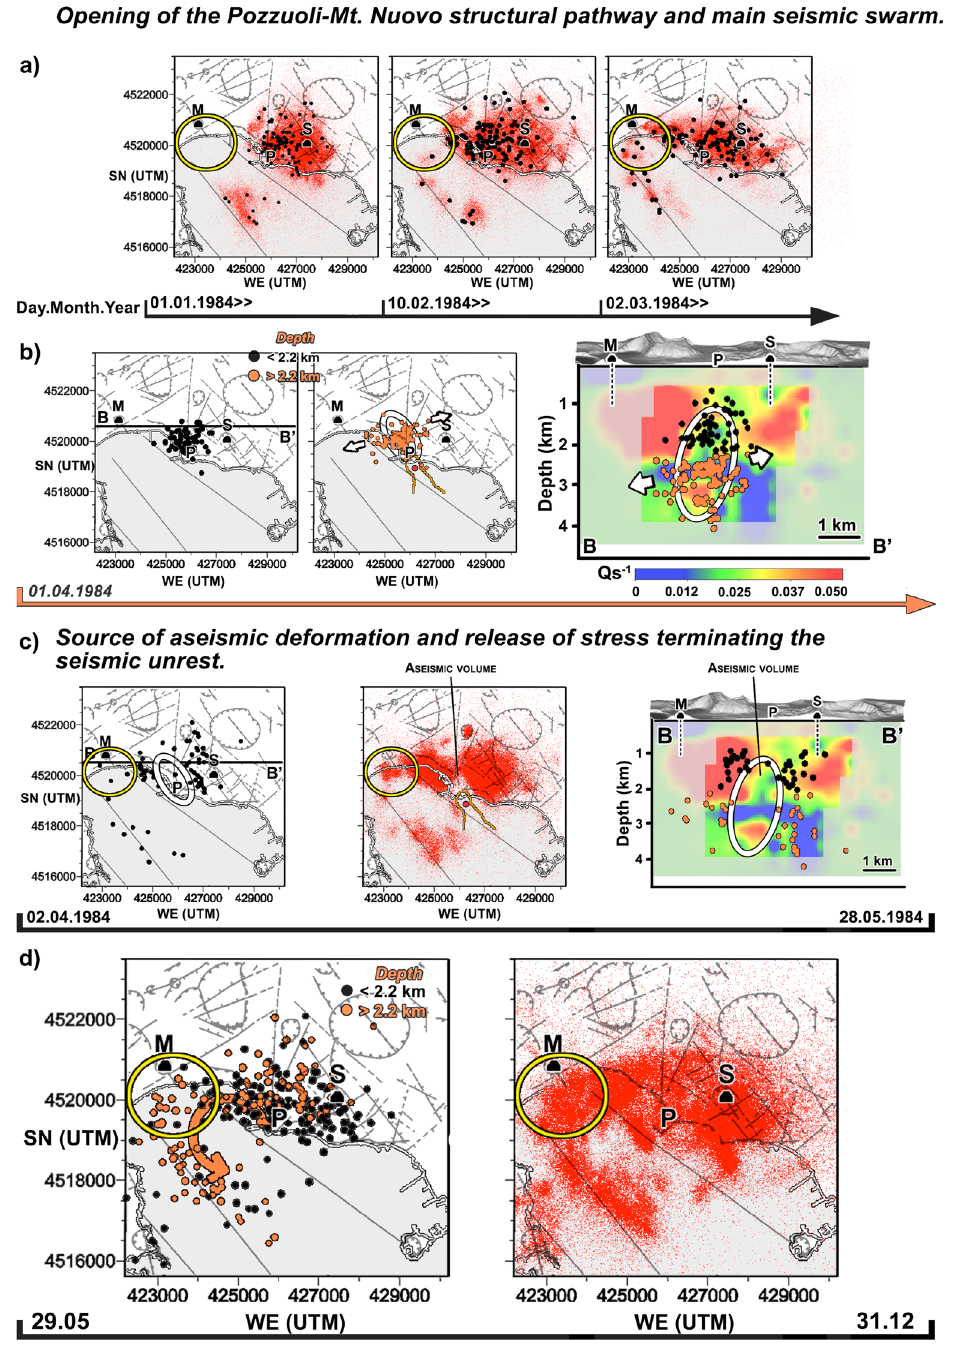
Figure 5. Time-dependent seismicity during the 1984 unrest. The symbols are the same used for Fig. 4. An 1 is plotted on all maps between January and May and depicts the 4–4.5 deep isoline corresponding to = . − Q 0 03 s high-attenuation anomaly. Panel (a) shows how the microseismicity progressively crosses the location of the last eruption, mainly following La Starza marine terrace. Panel b depicts the microearthquakes recorded on April 1: in this case, black (orange) circles are earthquakes recorded above (below) the maximum depth of the caprock 14 . The white ellipsoidal contour on the map and BB’ vertical section shows the area of densest microseismicity. In panel c, this same area becomes aseismic for 2 months. Almost no maximum likelihood hypocentres is located in the ellipsoid (left and right plots) while the PDF show a clear gap under Pozzuoli (central plot). Panel d depicts the end of the seismic unrest, with earthquakes repeatedly crossing the are of Mount Nuovo below the caprock (orange dots, see also the PDF) and following a NNW-SSE striking fault offshore 21, 31 . The figure wa created using the same softwares and data described in Fig. 4 (ESRI ArcGIS 10.0 © , https://www.esri.com/ training/catalog/5763042b851d31e02a43ed4d/using-arcmap-in-arcgis-desktop-10/; Voxler 3.0 © , http://www. goldensoftware.com/products/voxler; Photoshop CS © , https://helpx.adobe.com/uk/x-productkb/policy- pricing/cs6-product-downloads.html; SeismicityViewer,